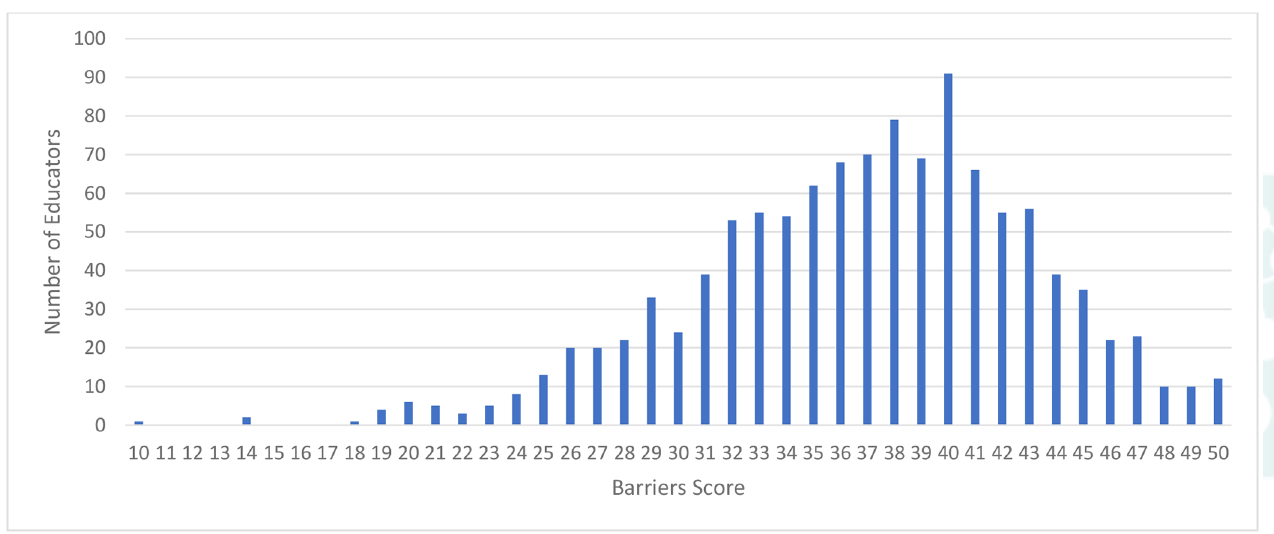
Figure 1: Sum of the score of educator-reported barriers to distance learning in kindergarten (N =